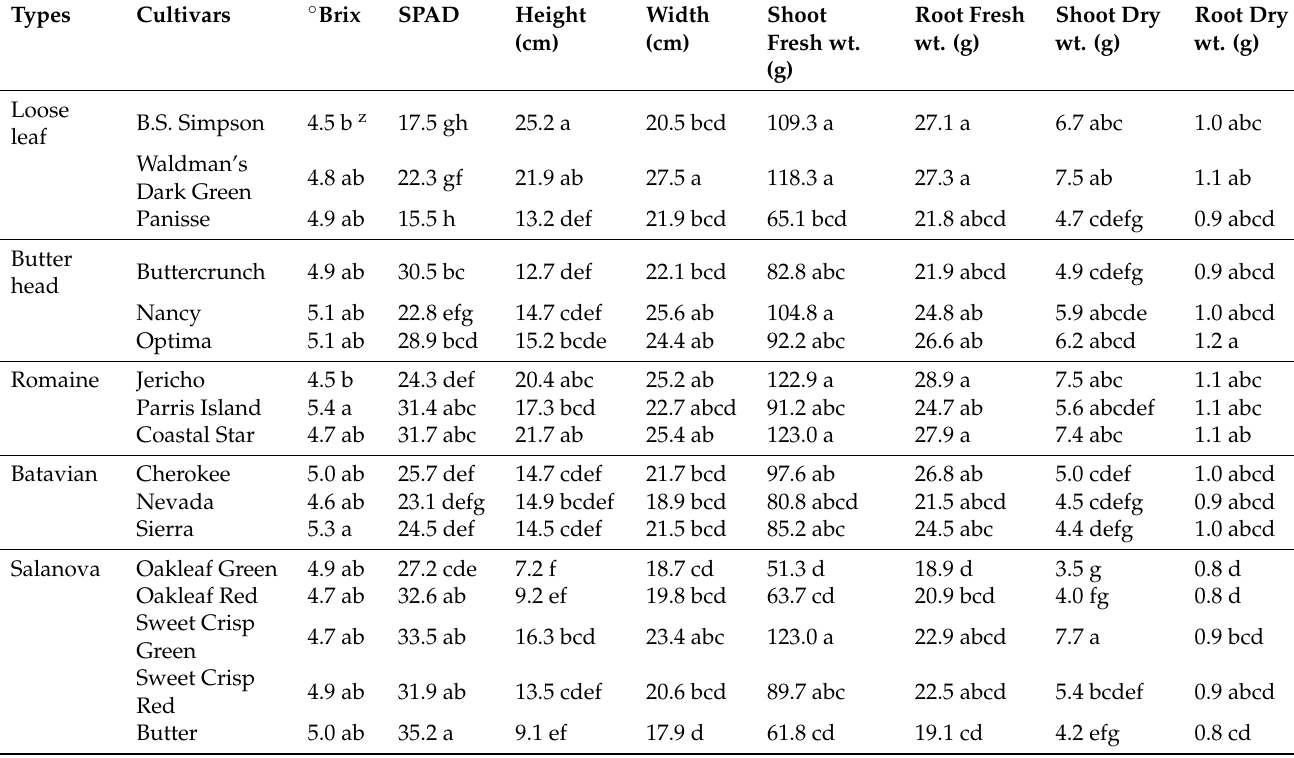
Table 4. Least square means for five types and seventeen cultivars on growth and quality of lettuce grown in NFT hydroponic systems at OSU research greenhouses in Stillwater, OK.